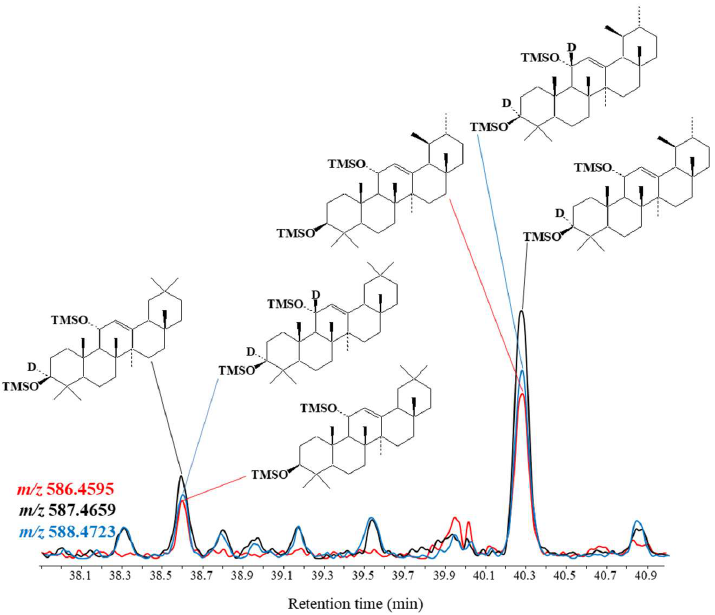
Figure 4. GC-QTOF characterization of amyrin oxidation products after deuteration.